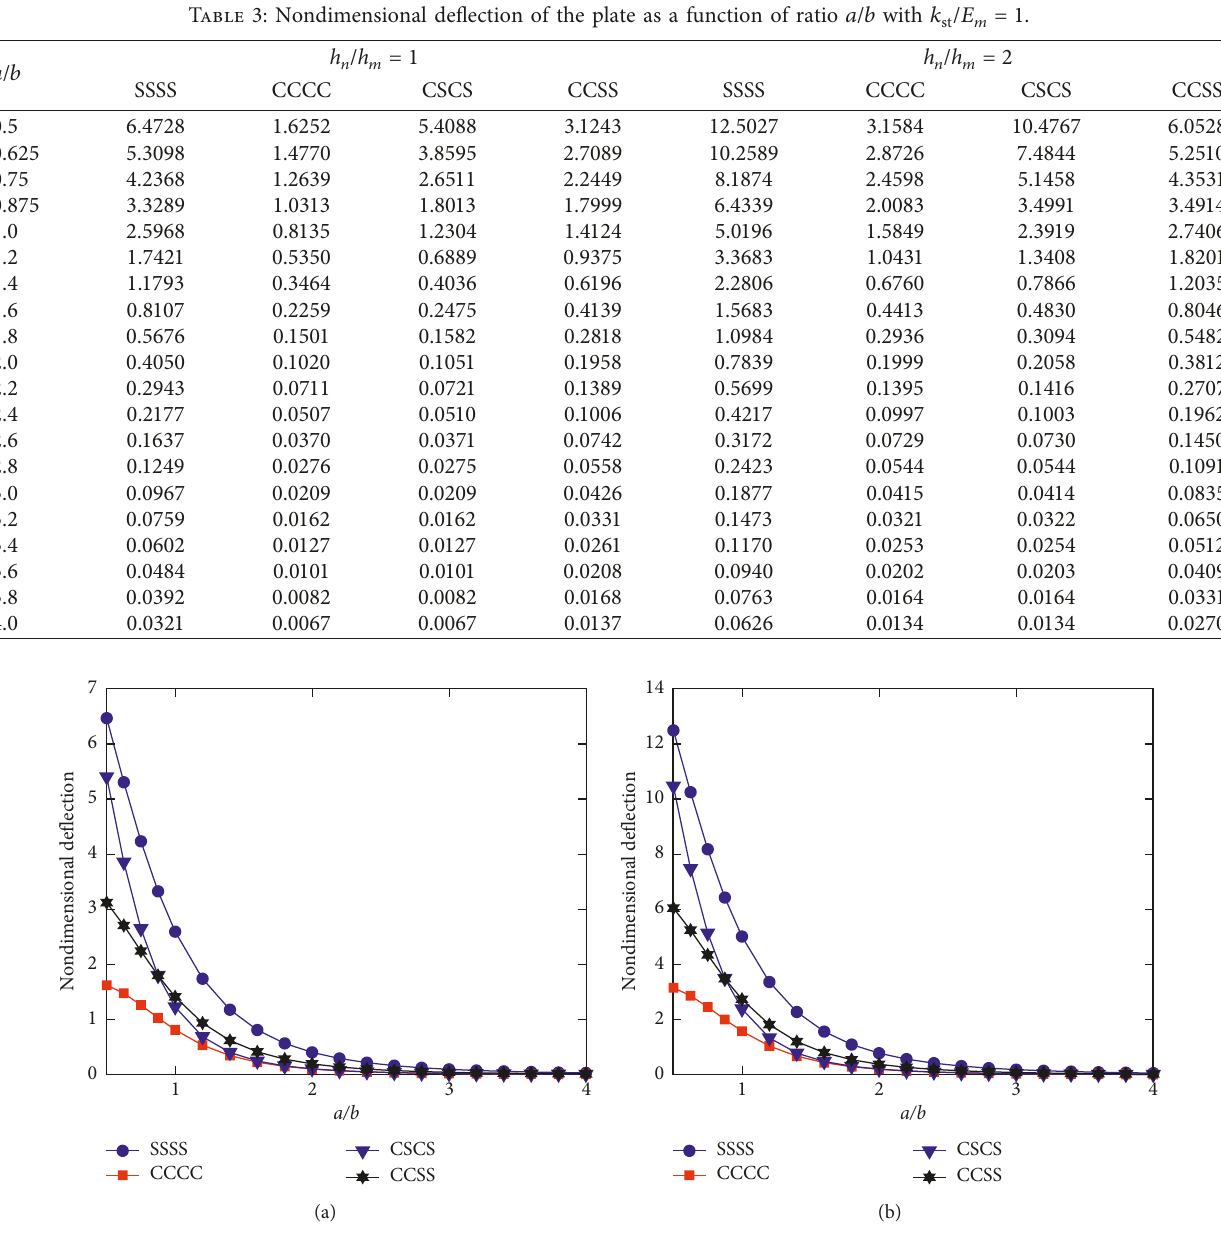
Figure 4: The influence of ratio a / b on the nondimensional deflection of the plate with k